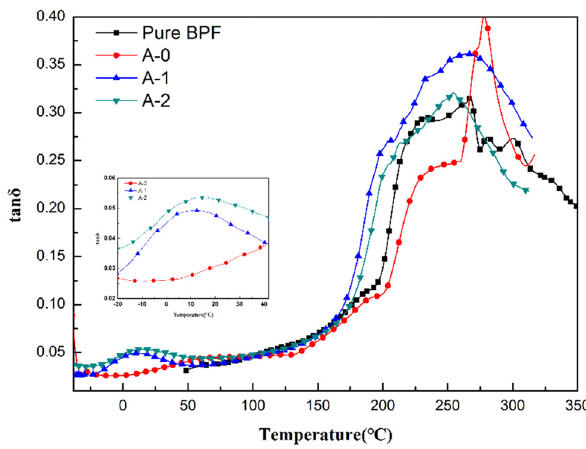
Figure 9: tan δ of the composites with temperature.